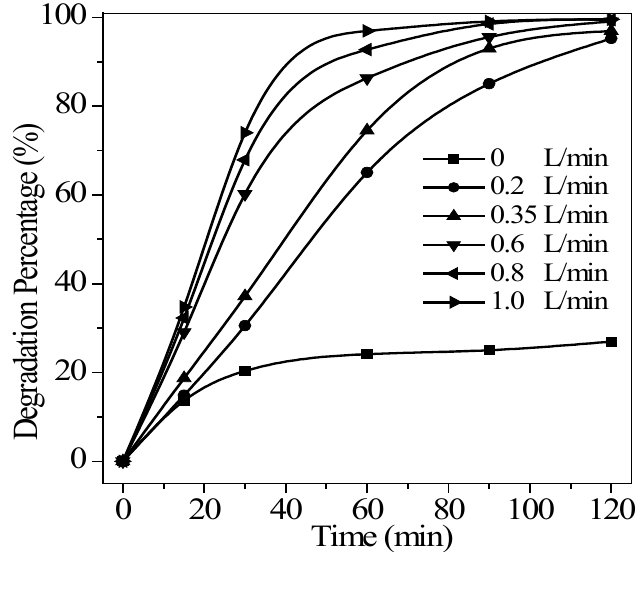
Figure 9. Effect of air flow on the photocatalytic degradation of quinoline. Conditions: pH = 6.7, T = 17 °C, C = 40 mg/L, and the maximum irradiation 0